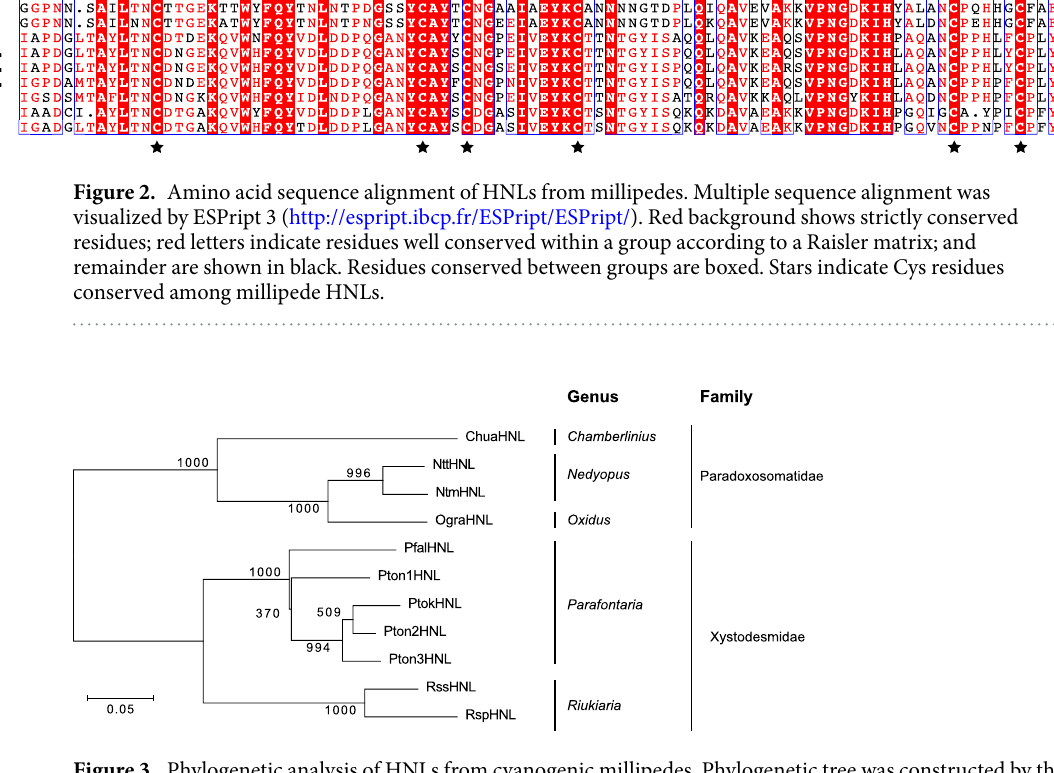
Sf9 E. coli BL21(DE3) E. coli SHuffle T7